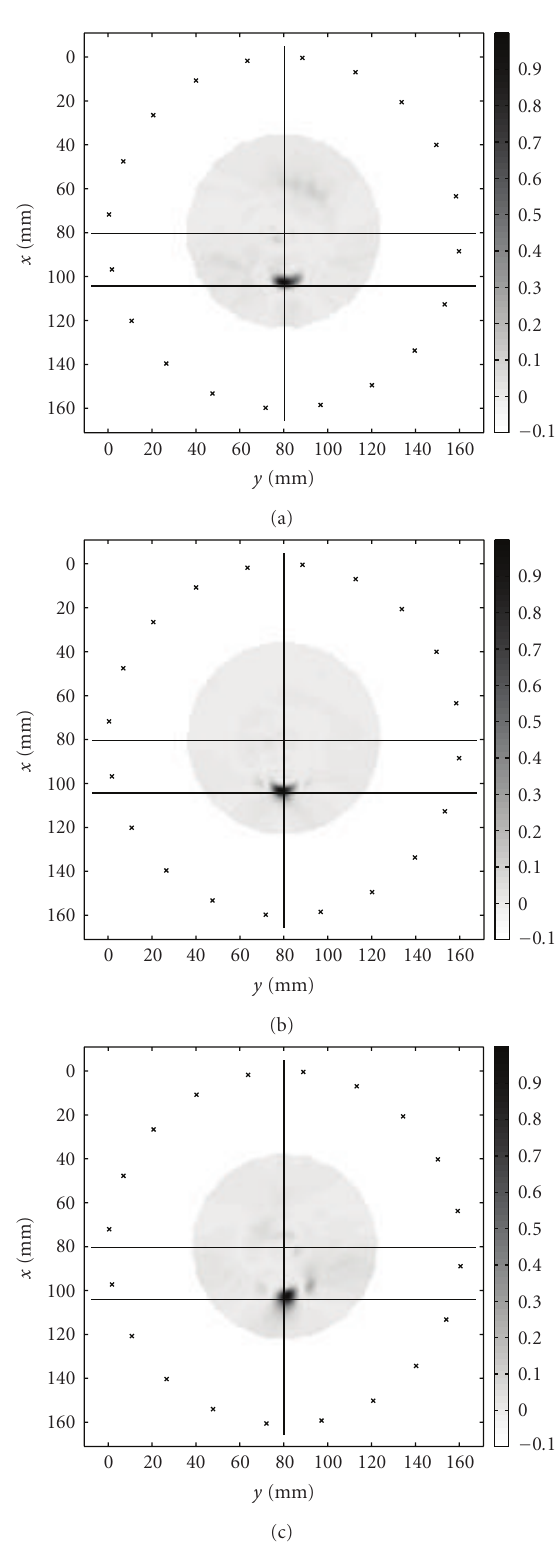
Figure 13: Comparison of focused tumor response between BAVA (a), BAVA-D (b), and TEM horn (c). The upper horizontal line shows the center of the phantom, while the lower shows the expected inclusion location along the x -axis. The vertical line shows the expected inclusion location along the y -axis. Each image is normalized to the specific